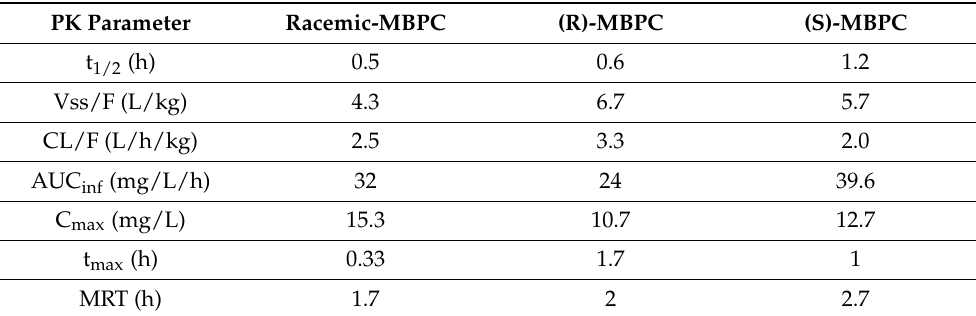
Table 1. Mean pharmacokinetic (PK) parameters of 3-methylpropyl(4-sulfamoylphenyl)carbamate (MBPC) (racemate) and its two individual enantiomers calculated from plasma levels following i.p. (80 mg/kg dose) administration to rats.